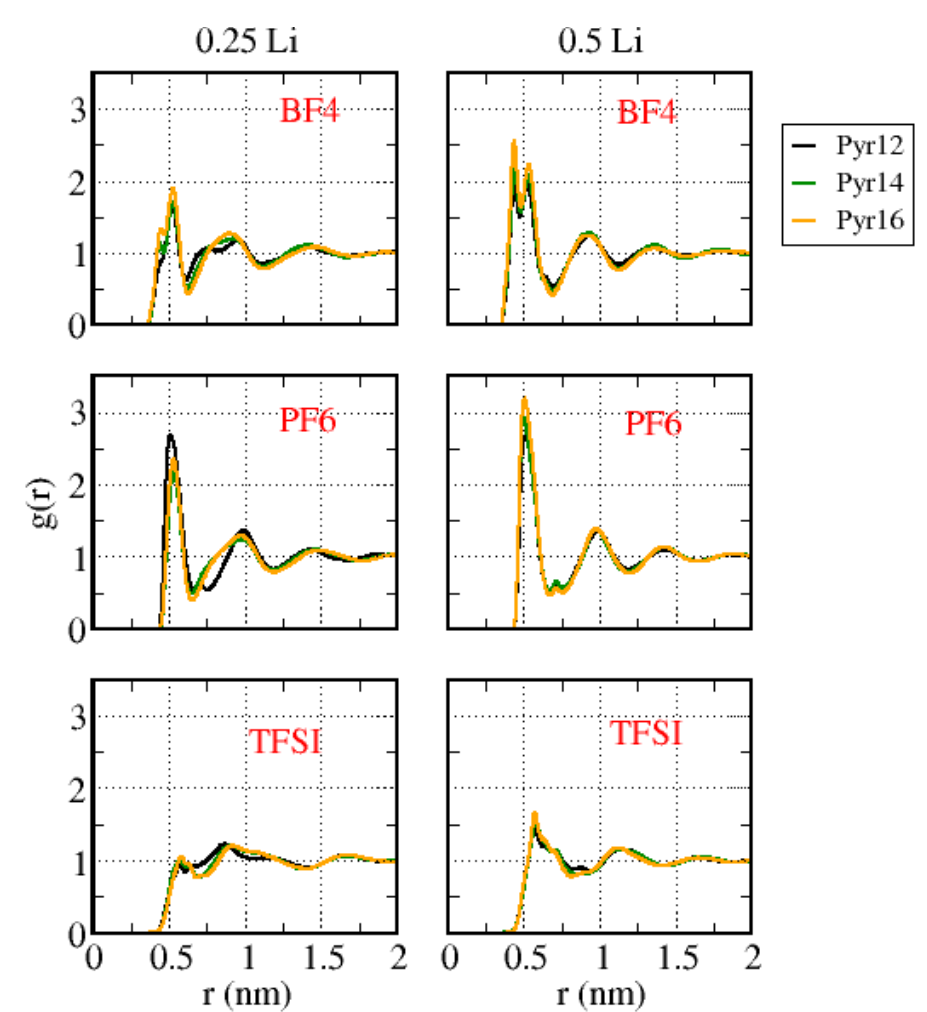
Figure 10. Center-of-mass anion–anion g ( r ) for all the systems with different amounts of lithium. Based on the results of g ( r ), we propose a strategy to understand how the ions aggre- gate in the system: considering the Li–anion distance ( r ) obtained from g ( r ), we used a Gromacs tool to select all Li cations in the box and to count how many anions there were at a distance r of those Li-ions, then divided by the number of Li–ions in the system, along the trajectory. From this result, we built the histograms shown in Figure 12, (a) for systems with 0.25 Li and (b) with 0.50 Li. From these results, we can observe that, in Pyr1X–BF4: 0.25 Li, the Li-ions were on average close to more than two anions. Systems with PF6 as the anion had a non-linear behavior: with Pyr13 and Pyr14, Li was close to less than 2 anions, and with Pyr12, Pyr15, and Pyr16, Li was close to more than 2 anions. Finally, systems with TFSI as the anion had only one TFSI close to each Li in most cases, the exception being the system with Pyr14–TFSI. Therefore, we suggest that Li-ions form clusters with the anions, which reduces their mobility, as happens in systems with imidazolium-based ionic liquids combined with the same anions and different amounts of lithium